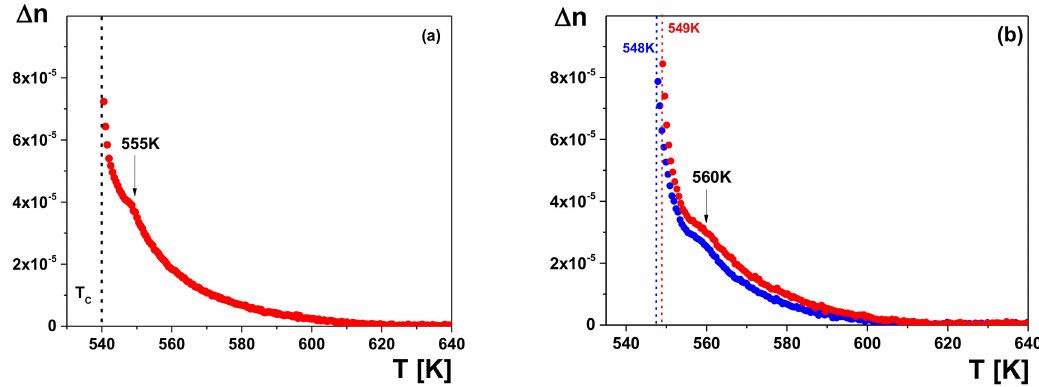
Figure 7. The temperature dependence of birefringence above T C. ∆ n was calculated for a region of 25 µ m × 30 µ m for processes of heating (red) and cooling (blue). ( a ) In non-polarized single PbZ 0.87 Ti 0.13 O 3 crystal; ( b ) under electric field having the strength of E = 7 kV /